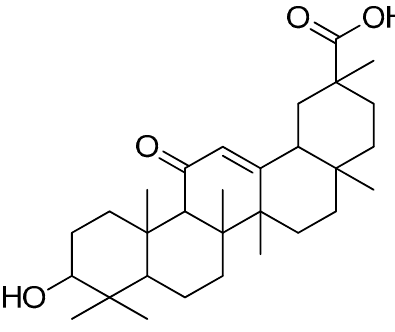
Figure 18. ( a ) Betulin-L-lysine; ( b ) betulin-L-ornithine.